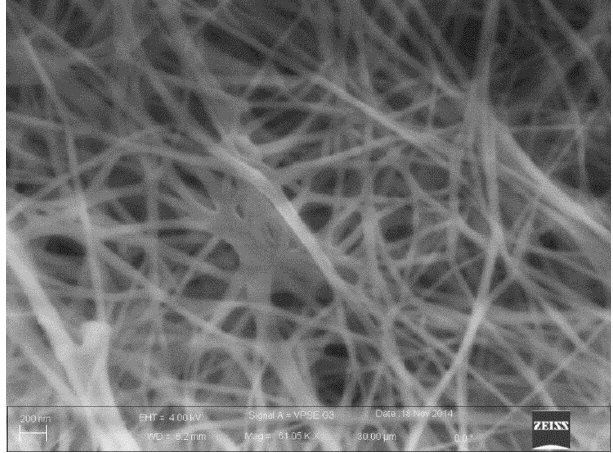
Figure 2. Scanning electron microscopic morphology of pure BC.